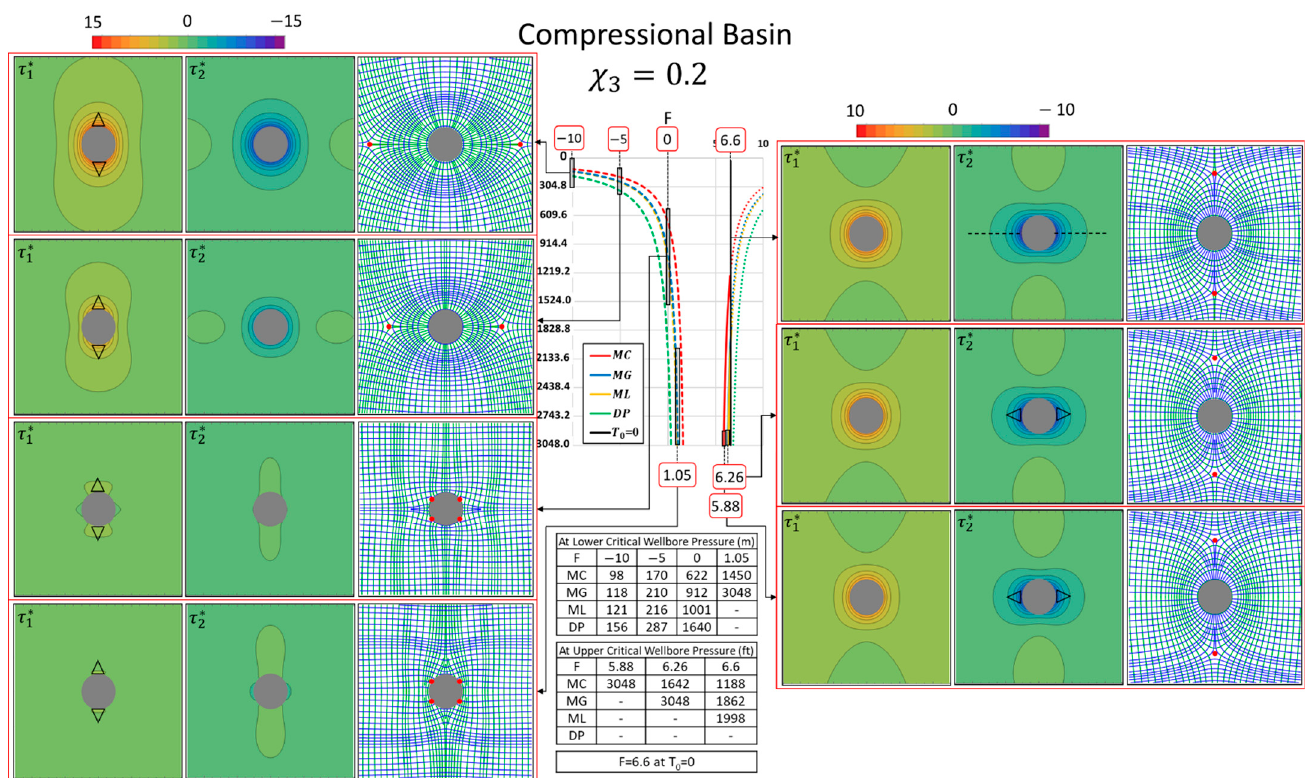
Figure 9. Dimensionless deviatoric stress magnitudes and trajectories for the compressional basin (reverse faulting) case at upper-bound (left-hand side) and lower-bound shear failure (right-hand side). For the zero tensile strength, tensile failure will occur at F = 6.6. The color indices above the magnitude plots indicate the local stress intensity is normalized by the larger (compressional) far-field stress (see Appendix B.6). The triangles and dashed lines on the magnitude plots of the maximum principal stress at shear failure and of the minimum principal stress at tensile failure show the expected locations of failure. The blue and green curves, and the red dots in the stress trajectory plots represent the maximum and minimum principal stress trajectories, and the neutral points, respectively. The tables beneath the F curves show the depths for each F value calculated by the Mohr–Coulomb (MC), Mogi–Coulomb (MG), modified Lade (ML), and Drucker–Prager (DP) failure criteria.